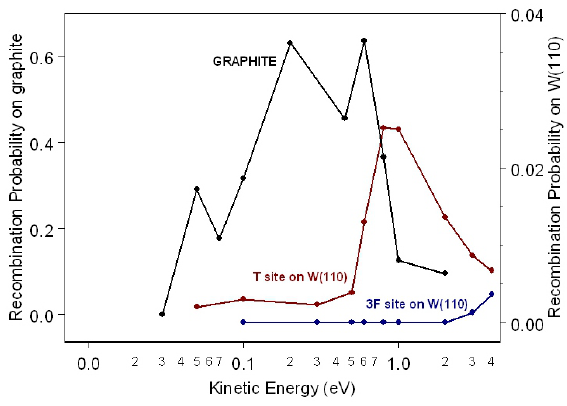
Figure 5. Eley–Rideal (E-R) recombination probability as a function of the kinetic energy for H